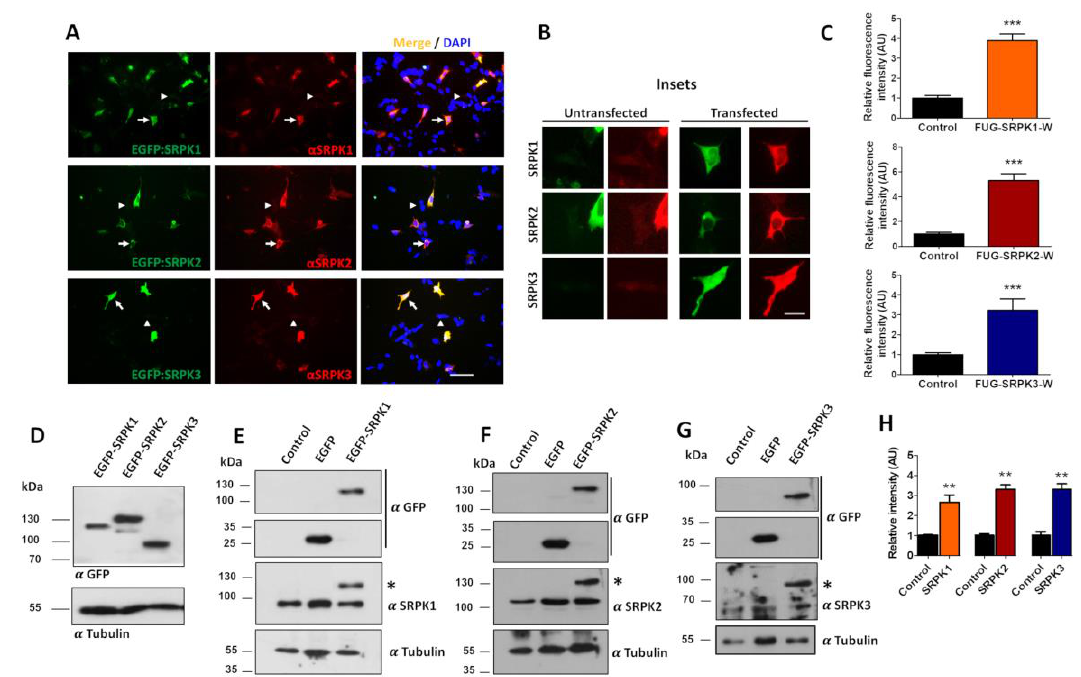
Figure 2. Characterization of SRPK1, -2 and -3 overexpression in SH-SY5Y cells. ( A ). Representative images of cells transfected with pEGFP-SRPK1, -2 and -3 plasmids. Forty-eight hours after transfection cells were fixed and stained for SRPK1, -2 and -3 with the respective antibodies (red fluorescence). Scale bar: 30 µm. ( B ) The insets are a magnification of cells represented in A, where a diffuse pattern for the three kinases is evident both in untransfected and in transfected cells. Scale bar: 10 µm. ( C ) Quantification of red fluorescence intensity in non-transfected and EGFP-SRPK1, -2 and -3 transfected cells. ( D ) Western blot analysis of SRPK1, -2 and -3 overexpression. Blots were detected with anti-GFP antibody showing the respective molecular size for the EGFP-SRPK1, -2 and -3. ( E – G ) Western blots were developed with kinase-specific antibodies comparing the expression and size of the EGFP-SRPKs with the respective endogenous kinases. The asterisks in these figures represent the EGFP-SRPK proteins. ( H ) Quantification of band intensity for the EGFP-SRPK proteins versus the endogenous kinases. Control bars represent endogenous SRPKs from untransfected cells, and SRPK bars represent endogenous SRPKs plus exogenous SRPKs. The amounts of plasmid used for transfection were 1.0 µg/well and (24-well plates, immunofluorescence) and 5.0 µg/well (six-well plates, Western blot). Data are presented as mean ± SEM, and statistical analysis was done by t -test, n = 20 cells (three independent experiments). ** p < 0.01; *** p < 0.001. Scale bar: ( A ) 30 µm and ( B ) 10 µm.